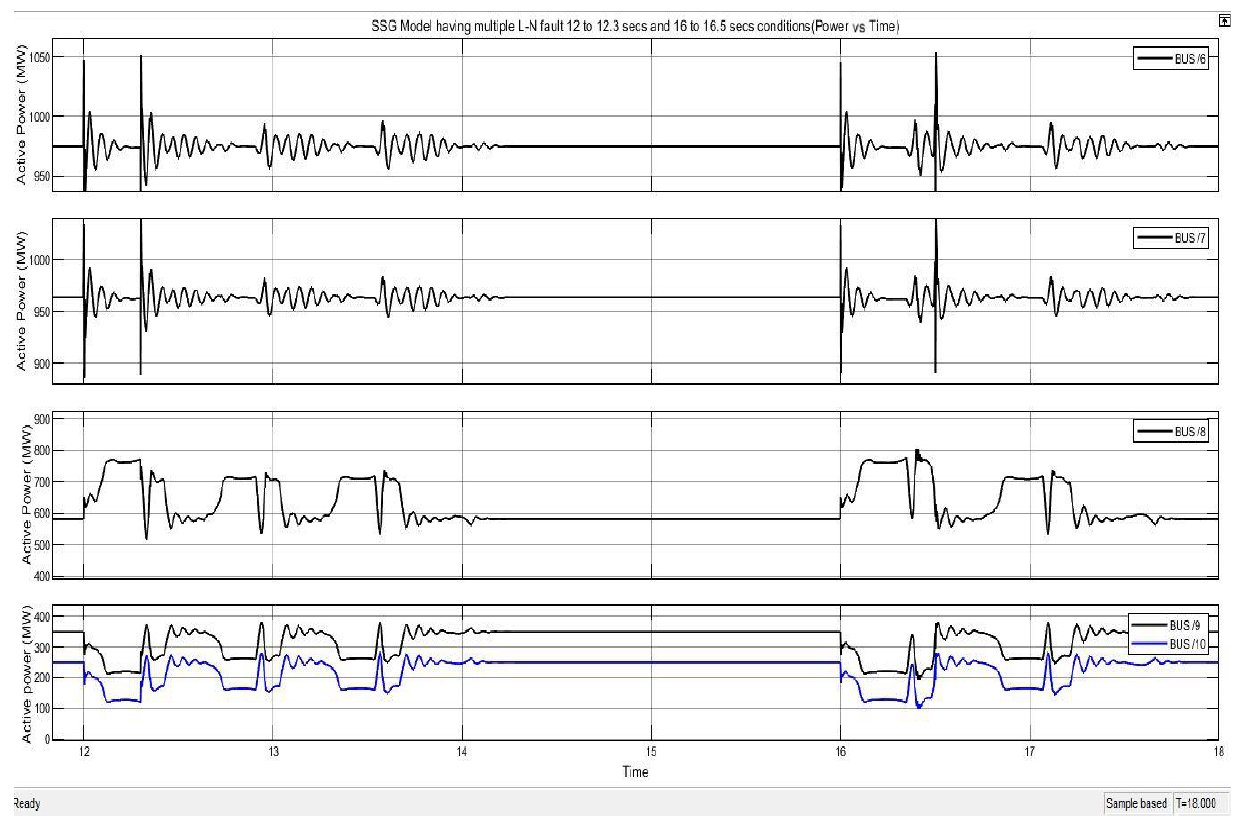
Figure 19. Multiple line-to-ground faults are inserted in the system from 16 to 16.5 s (Bus 1 to Bus 5).